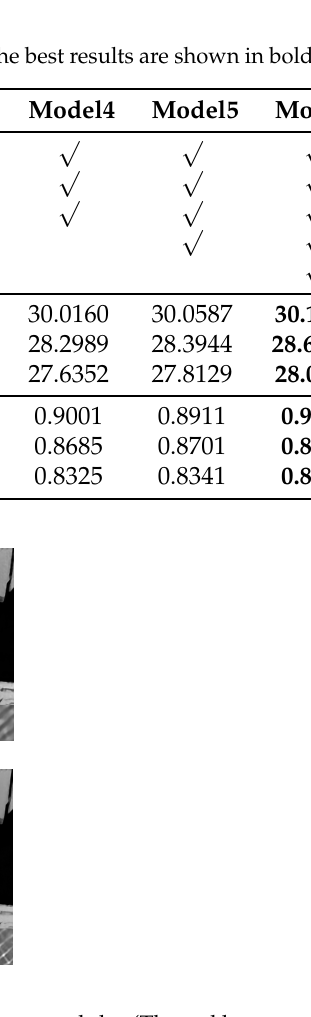
Figure 10. Restoration of severe turbulence blur using different modules (The red boxes represent the focus